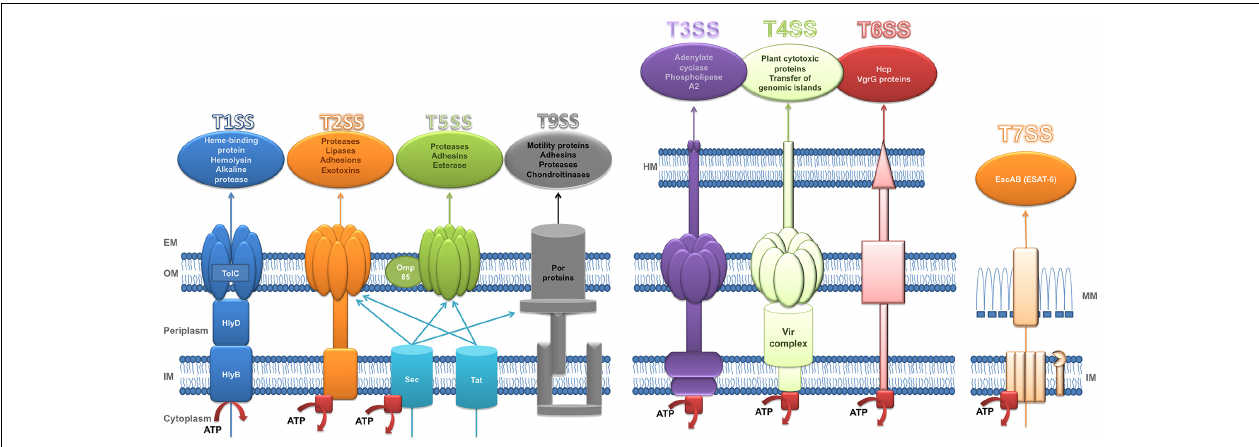
FIGURE 1 | Structure of secretion systems. Schematic representation of secretory systems: type I (T1SS), type II (T2SS), type V (T5SS), type IX (T9SS), type III (T3SS), type IV (T4SS), type VI (T6SS), and type VII (T7SS). The type I pathway is exemplified by hemolysin A (HlyA) secretion in E. coli where TolC, HlyD, and HlyB are the three components which constitute the channel to transport HlyA to extracellular space. Sec (general secretion route) and Tat (twin-arginine translocation pathway) transfer the substrates of T2SS and T5SS across the inner membrane. Sec also participates in the transport of T9SS substrates across de inner membrane. T9SS is also called Por Secretion System (PoSS). T4SS is represented by VirB/D system of Agrobacterium tumefaciens . The T7SS is based on a system in Mycobacteria. Red squares represent the ATPases. HM, host membrane; EM, extracellular medium; OM, outer membrane; IM, inner membrane; MM, mycomembrane. Substrates secreted by each secretory system are included in a circle in the top of the figure. Adapted from Tseng et al.